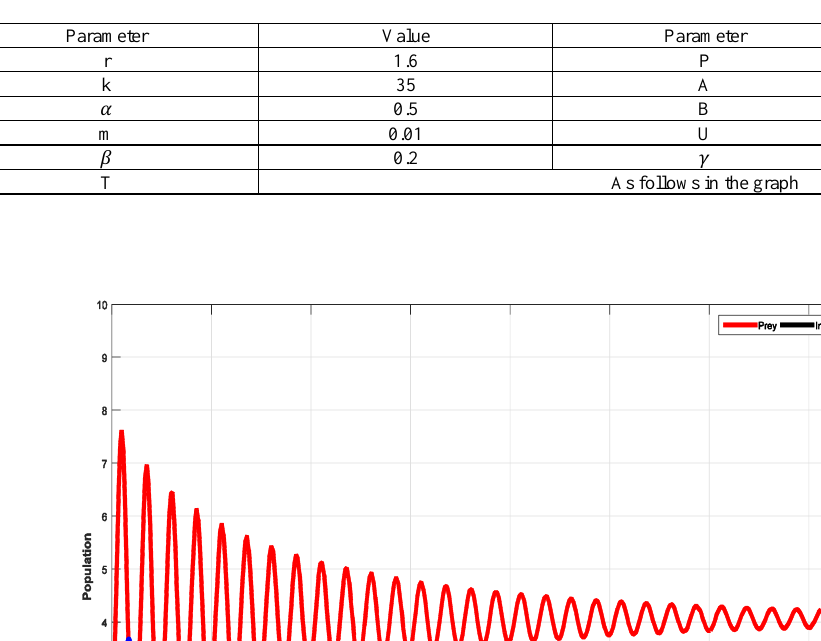
Table 1. Value of all parameters.